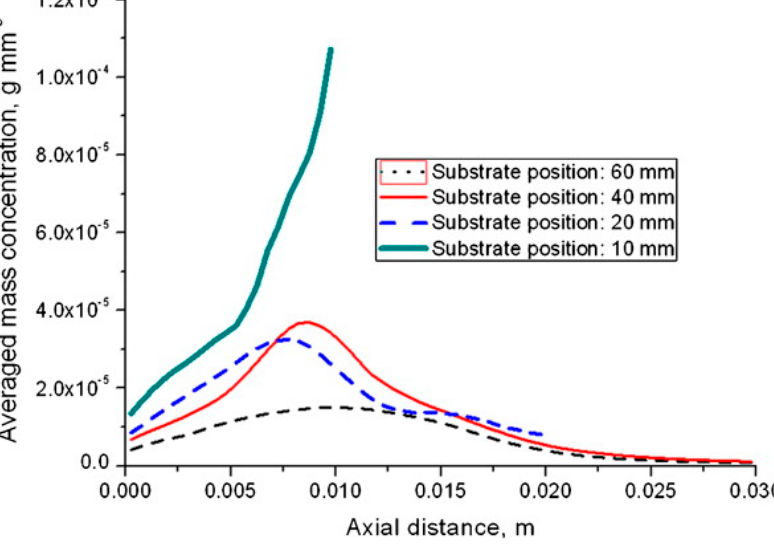
Figure 9. Effect of substrate position on particle concentration (reproduced with permission from [63]; Copyright © 2010 Elsevier).